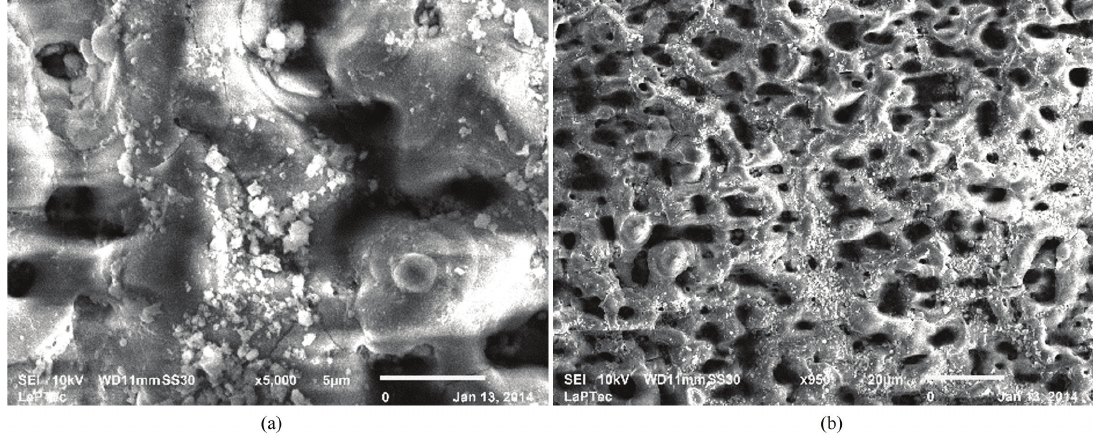
Figure 7. SEM micrographs with two magnifications of red mud